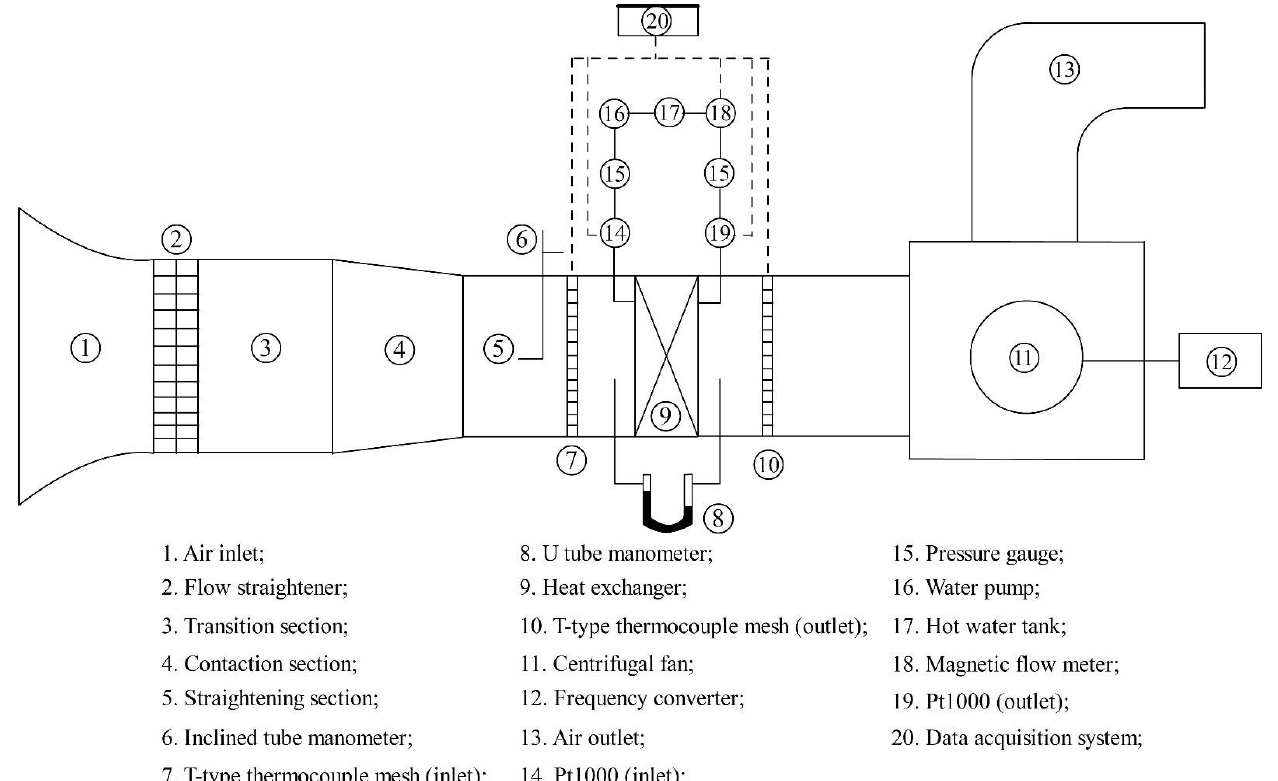
6 of 15 Table 3. Parameter table for circular-arc-shaped flow channels. NO.